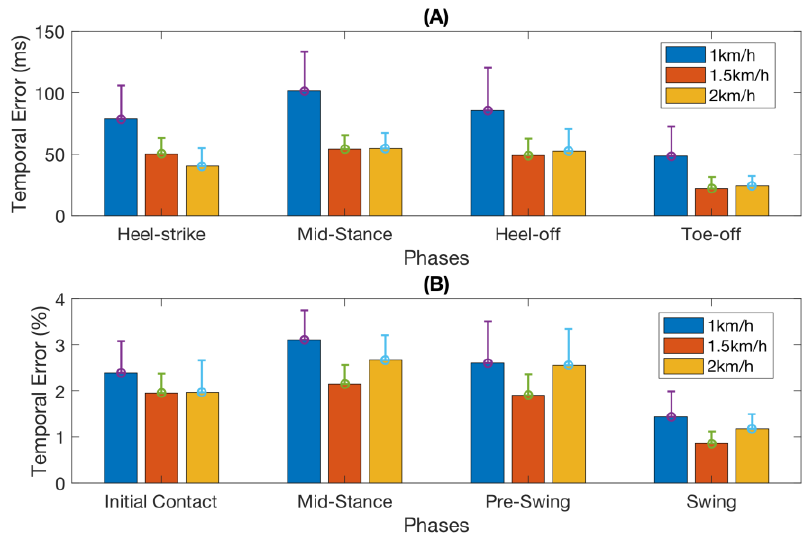
Figure 5. Mean temporal error for each phase across nine subjects spanned by three speeds. ( A ) The absolute temporal error of the phase transitions; ( B ) Relative temporal error. The error bars stand for 1 standard deviation.